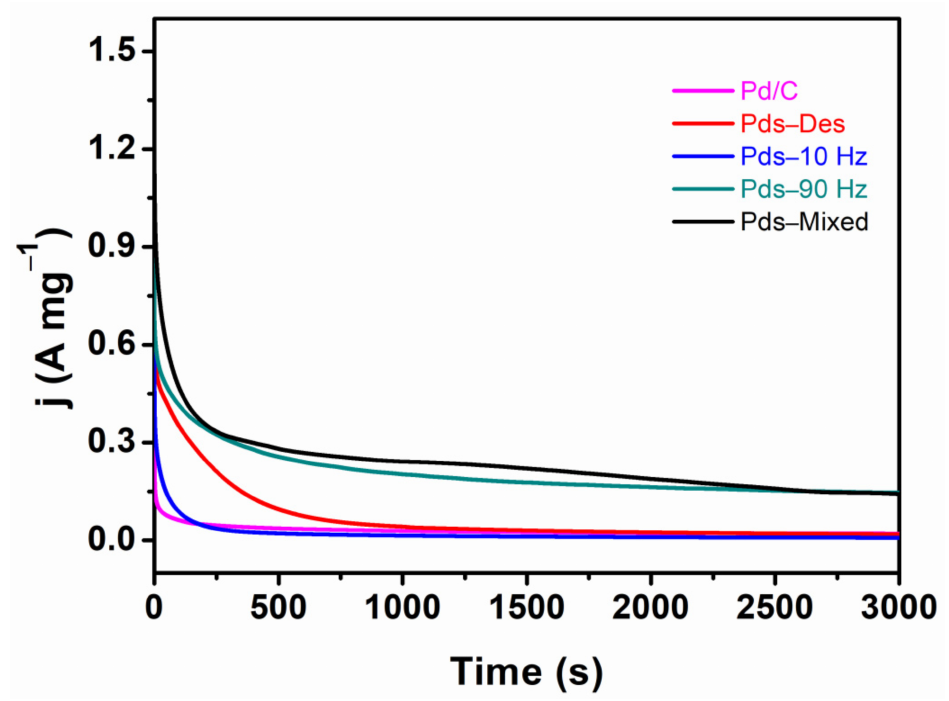
Figure 7. Chronoamperometric curves of FAO on Pd/C, Pds–Des, Pds–10 Hz, Pds–90 Hz, Pds–Mixed in 0.5 M HCOOH + 0.5 M H 2 SO 4 solution at 0.15 V for 3000